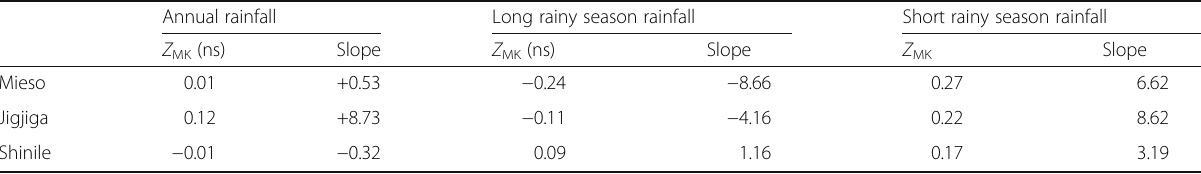
Table 1 Trends of annual rainfall and seasonal rainfall for the period 1984 – 2015 in pastoral, production systems of Mieso, Jigjiga, and Shinile districts of eastern